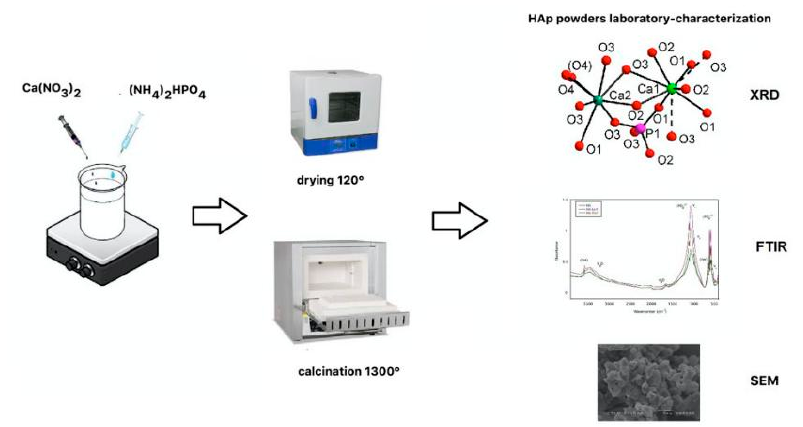
Figure 1. Hydroxyapatite (HAp) synthesis, and first characterization in